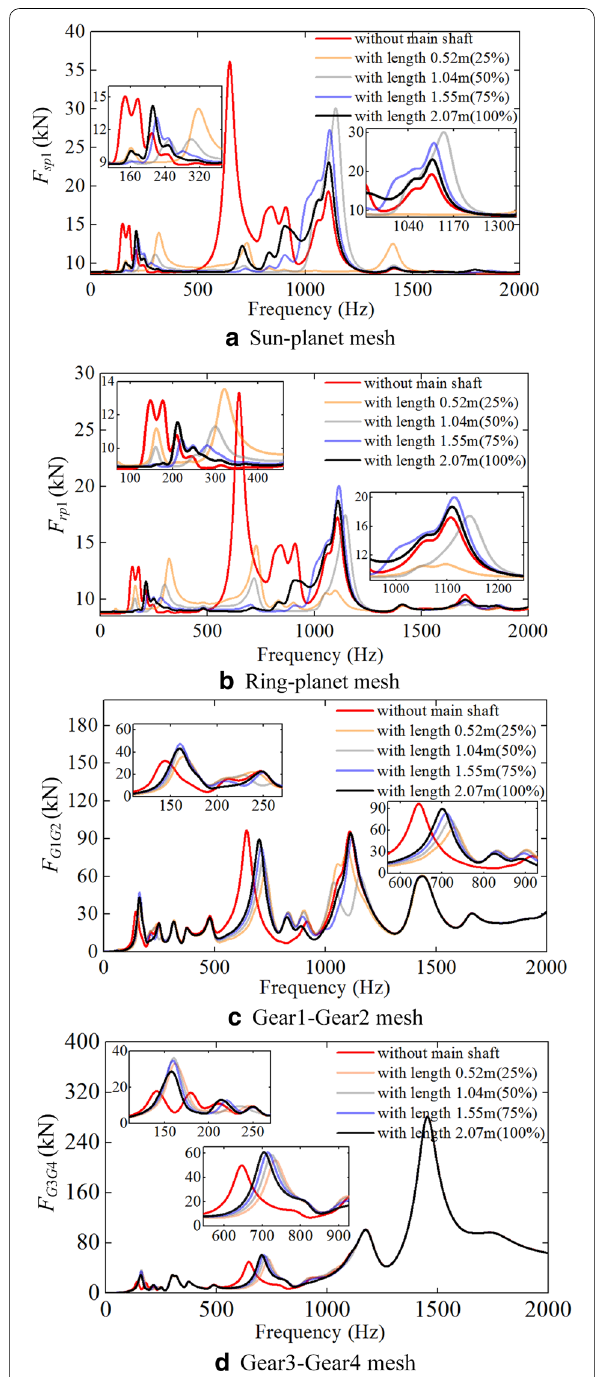
Figure 8 Dynamic mesh